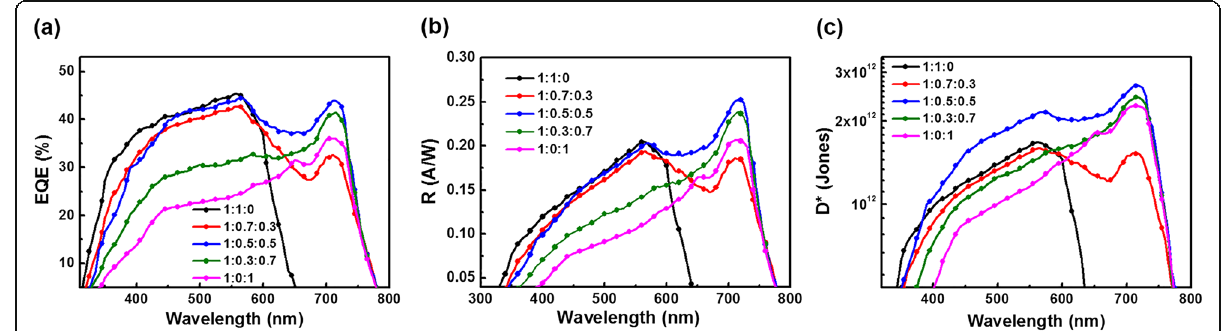
Fig. 6 a Measured EQE spectra of OPDs with various ratios. b Calculated R values of OPDs. c Calculated D * values of OPDs